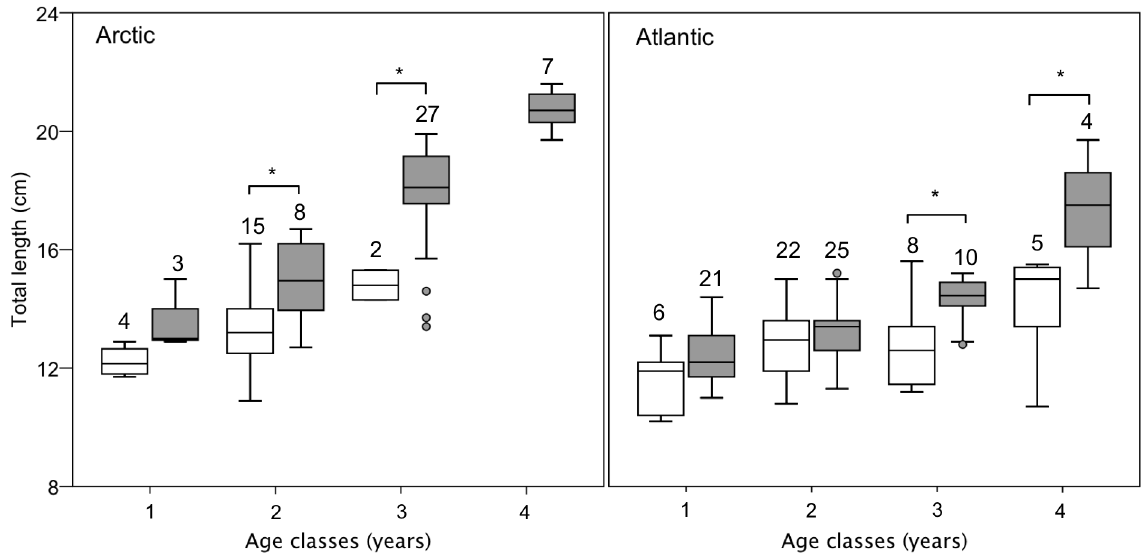
Figure 5. Total length (cm) of polar cod in relation to otolith based age (years) and maturity status. Mature (grey boxes) and immature (white boxes) individuals sampled in January 2011, 2012 and 2013 within the Arctic (n=66) and Atlantic (n=104) domains. For both domains, both genders were merged due to otherwise small sample size and because gender was not found to explain variability in length in the linear model operating on the larger dataset. Plots represent the median (line), 25%–75% percentiles (box), non-outlier range (wisker) and outliers (circle). Numbers above each box are n. Asterisks show significant (t-test without corrections for multiple comparisons, p , 0.05) differences between mature and immature fish within domain and age-group.